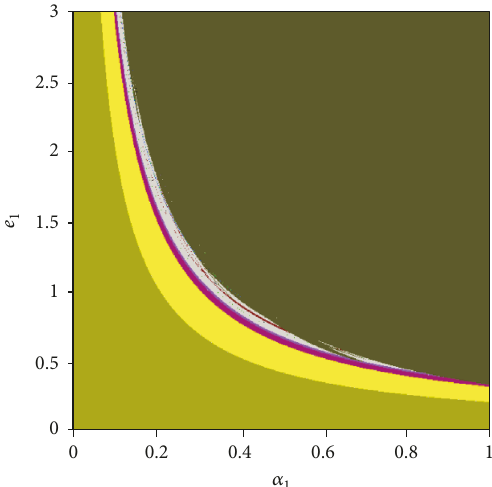
Figure 5: (𝑒 1 ,𝛼) -2D bifurcation diagram with 𝛽 = 0.25 and 𝛾 = 0.1 .